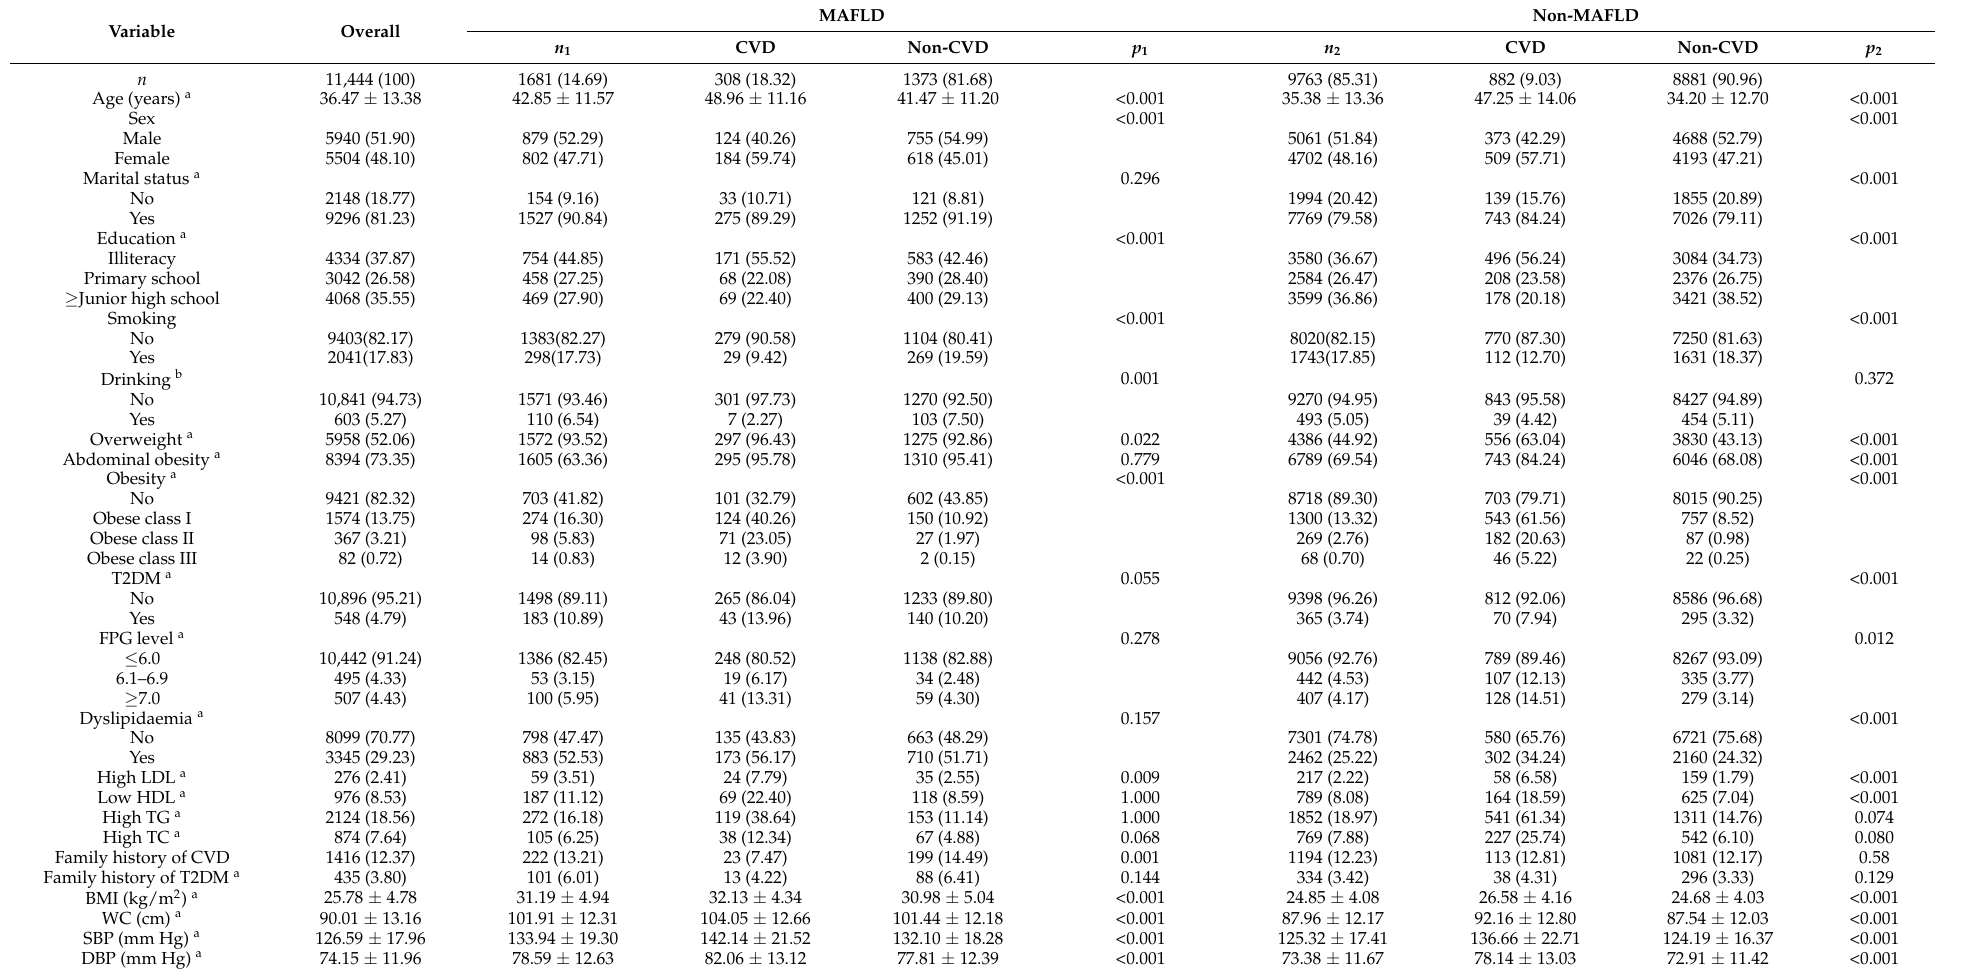
Table 1. Baseline characteristics of the participants grouped by the presence of metabolic dysfunction-associated fatty liver disease and new cardiovascular disease